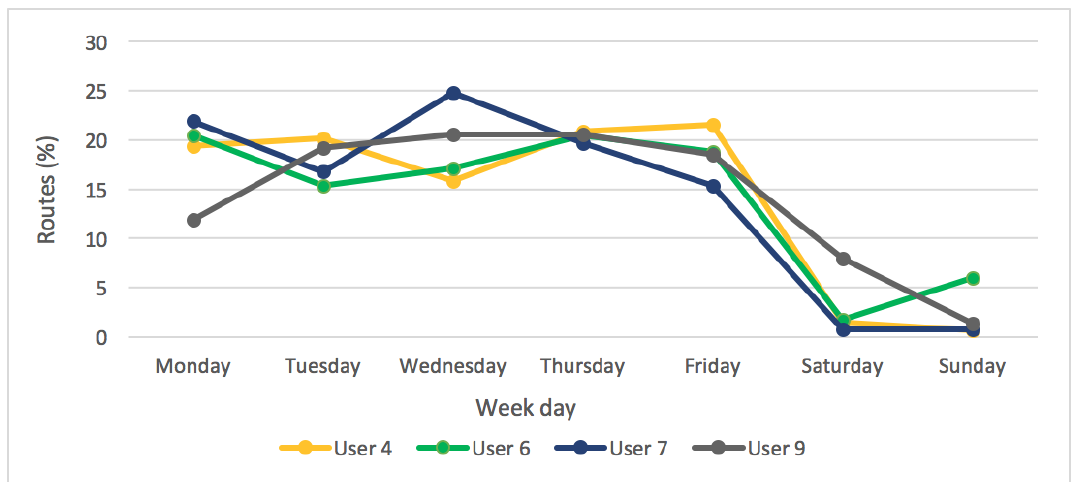
Figure 13. Distribution of the routes cycled by users from the second group over the week.